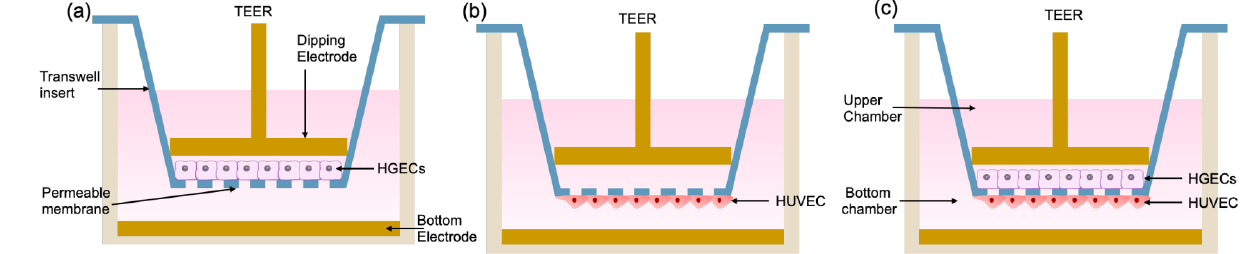
Figure 1. Schematic description of transepithelial/transendothelial electrical resistance assays. ( a ) HGECs are seeded onto the upper non-coated porous membrane of the transwell; ( b ) HUVEC are seeded onto the bottom non-coated porous membrane of the transwell; ( c ) HGECs and HUVEC are respectively cultured on the upper and bottom sides of the porous membrane within the transwell.